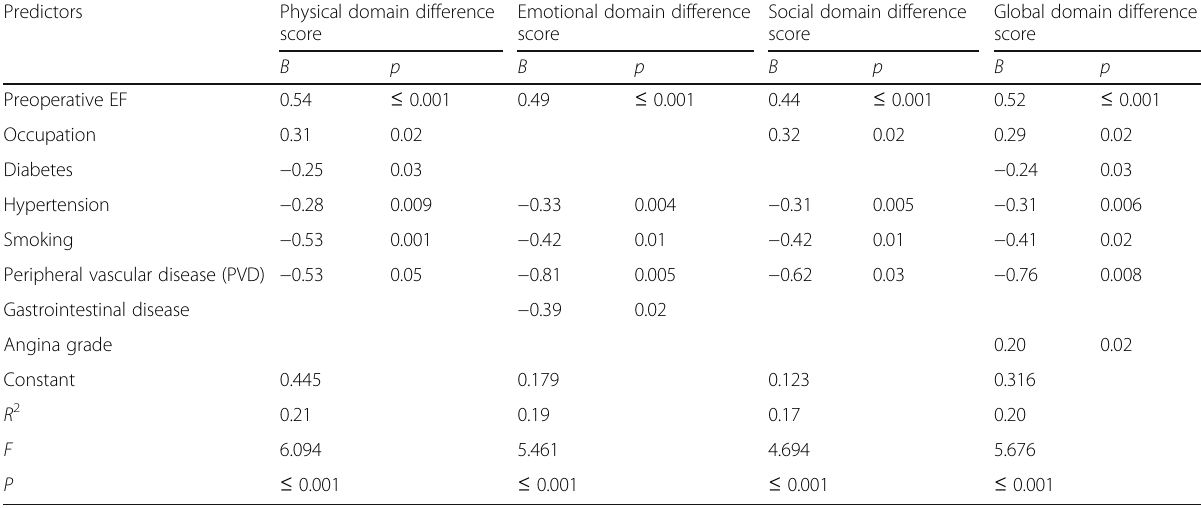
Table 3 Multiple linear regression analysis of follow-up independent predictors of physical, emotional, social, and global QOL- normalized difference score after 6 months of CABG